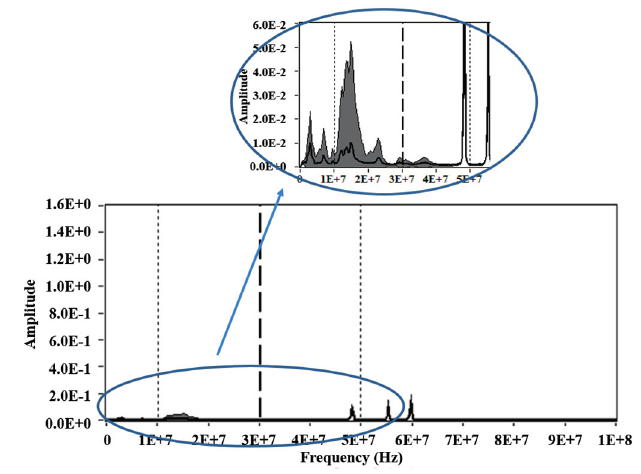
Figure 12. Average power spectrum density for PD and noise simultaneously